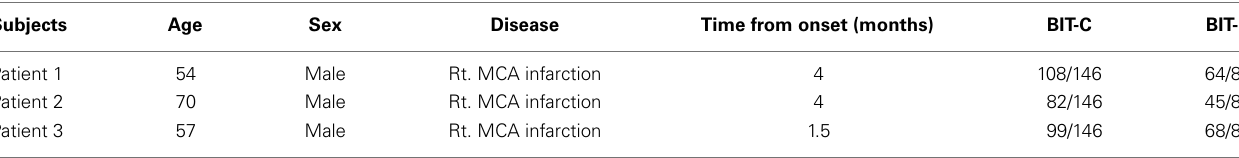
Table 1 | Demographic characteristics of all patients.